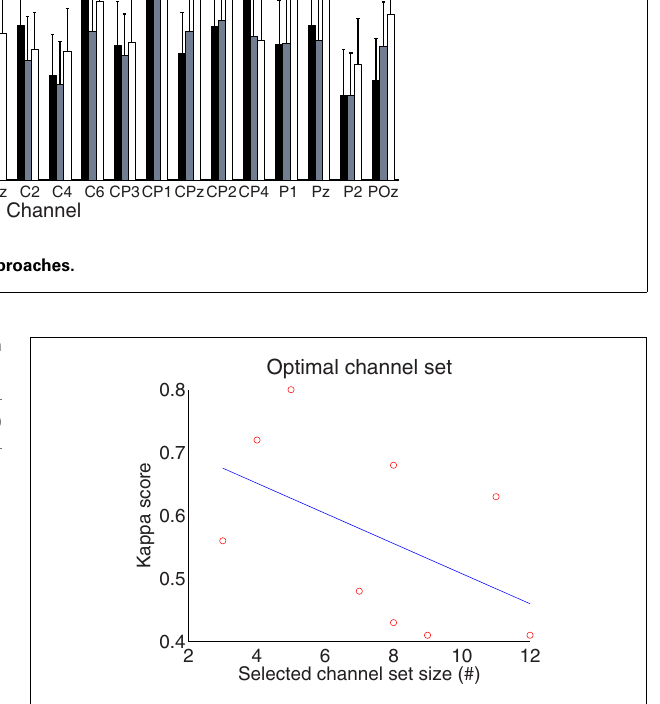
FIGURE 6 | Correlation between the selected channel set size and kappa